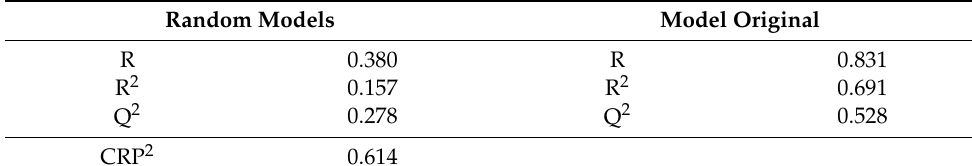
Table 3. Various values obtained after testing of